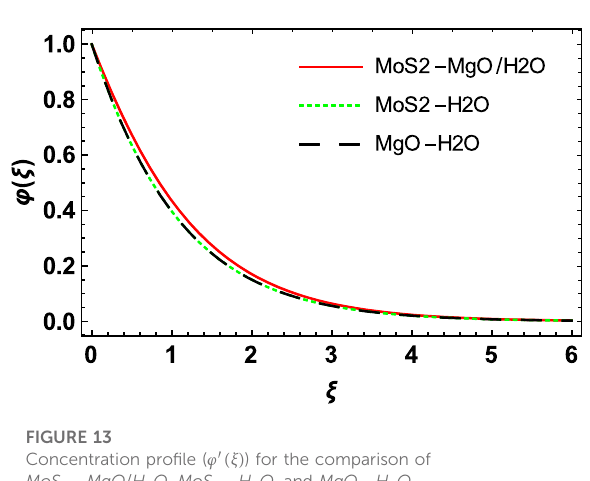
FIGURE 11 Velocity pro fi le ( g ′ ( ξ ) ) for the comparison of MoS 2 − MgO / H 2 O , MoS 2 − H 2 O , and MgO − H 2 O .